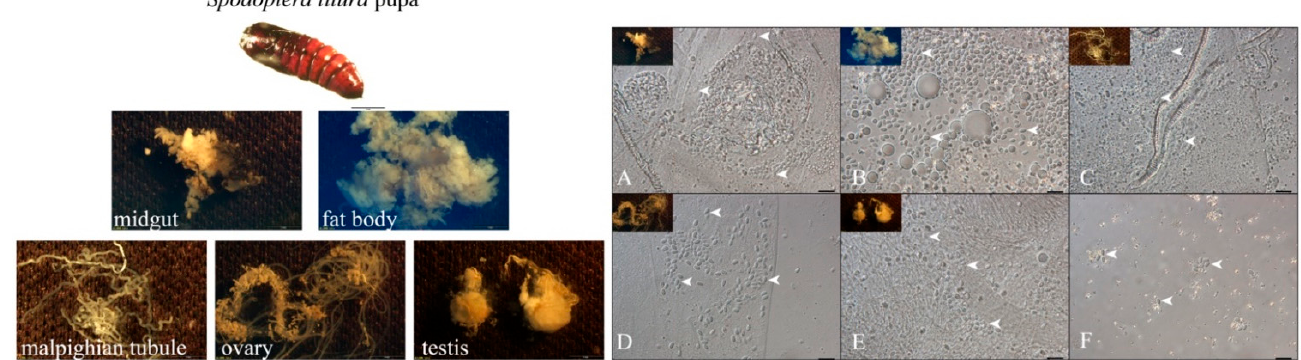
Figure 1. Microscopy observation of NbCQ1 infections in S. litura pupa tissues. ( A ) midgut, ( B ) fat body, ( C ) malpighian tubules, ( D ) ovary, ( E ) testis, ( F ) hemolymph. The bar indicates 10 µ m. The arrowhead shows the NbCQ1 spore.